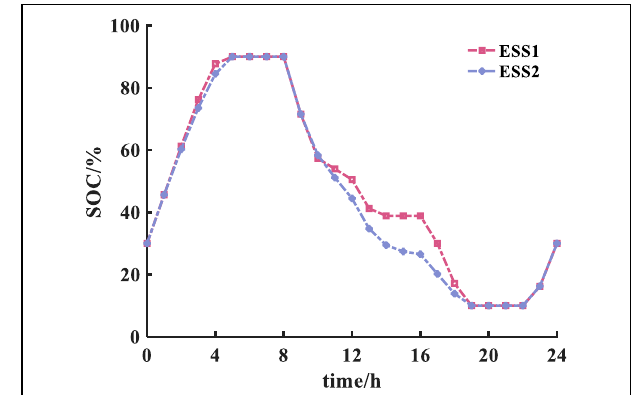
FIGURE 8 | Hourly load curves under three scenarios.